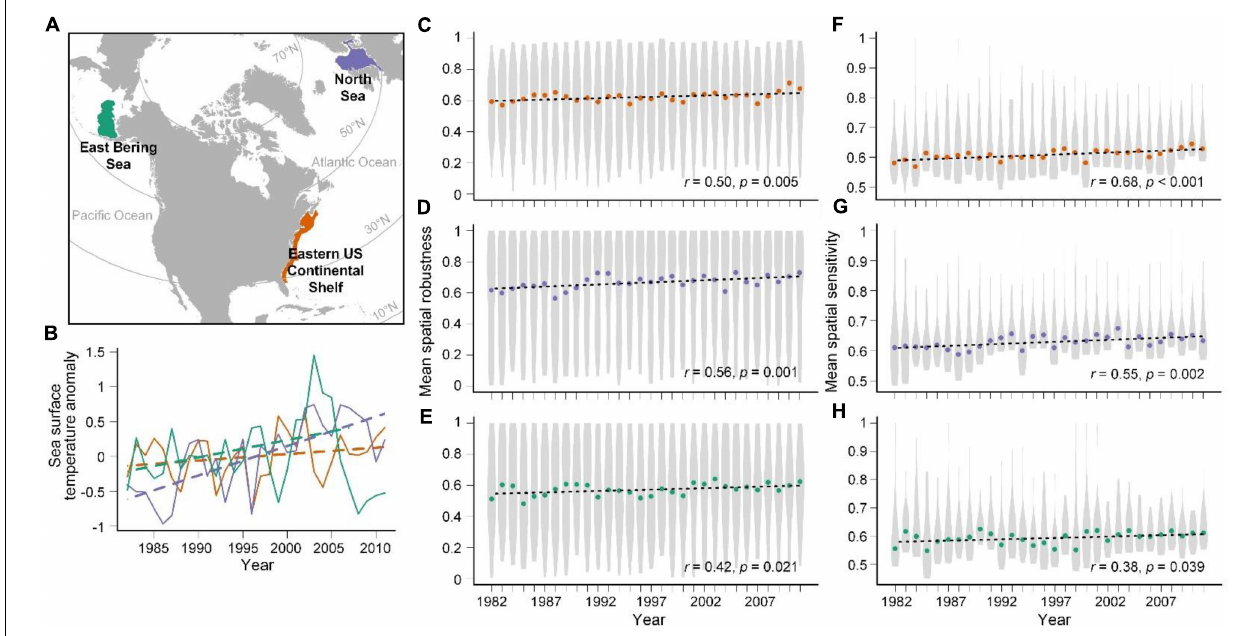
FIGURE 1 | Map of the three large marine communities (A) , SST anomalies (B) , temporal trends of mean spatial robustness (MSR) (C–E), and mean spatial sensitivity (MSS) (F–H) . Annual SST anomalies were calculated with respect to 1982–2011 climatology. SSTs in ◦ C were obtained from 1/4 ◦ daily Optimum Interpolation Sea Surface Temperature (OISST) data: AVHRR-Only, which used infrared satellite data from the Advanced Very High Resolution Radiometer (AVHRR) and were downloaded from NOAA’s National Centers for Environmental Information (NCEI). We calculated the mean SST value of each year according to the extracted spatial range of our study regions. A slowly increasing SST trend after 2008 is observed in the Eastern Bering Sea. Violin plots showing MSR (C–E) and MSS (F–H) in each year. Orange, purple, and green represent the results for the Eastern US Continental Shelf, North Sea, and Eastern Bering Sea, respectively. In the violin plots, circles represent median values, and the widths of the gray horizontal regions of the plots represent the density of the data along the Y -axis. The black dashed lines represent linear temporal correlations of MSR and MSS with year. The time-series correlation coefficients and p-values are